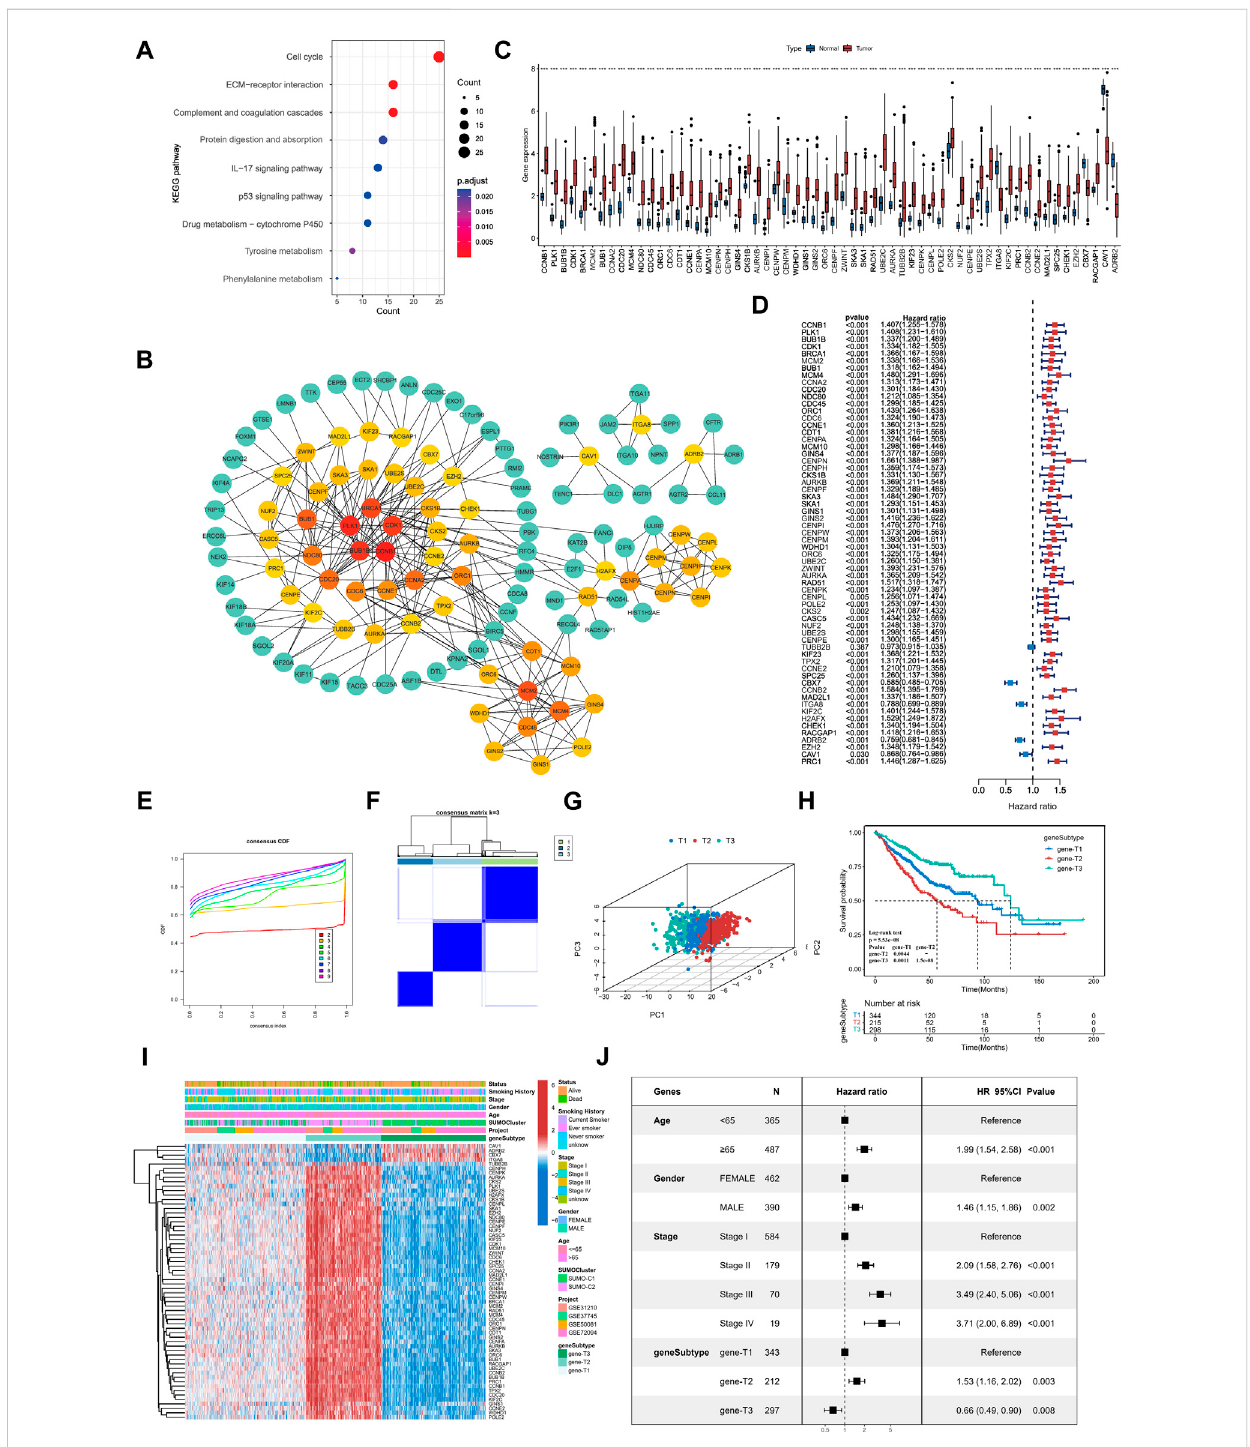
FIGURE 5 Identi fi cation of key genes differentially expressed between SUMOylation patterns and characterization of SUMOylation genomic subtypes. (A) Functional annotation of SUMOylation differential genes by KEGG enrichment analysis. (B) The Protein-Protein Interaction Network (PPI) of key genes associated with SUMOylation. (C) Differential expression of SUMOylation key genes between lung adenocarcinoma and normal tissue samples. (D) Prognostic value analysis of SUMOylation key genes for lung adenocarcinoma. (E) CDF curves for unsupervised clustering with K = 2 to 9. (F) ConsensusclusteringgraphwithK=3. (G) PCAofSUMOylationgenomicsubtypesbasedonkeygenestranscriptome. (H) Kaplan-Meiercurvesforoverall survival OS for the three SUMOylation genomic subtypes. (Log-Rank test p = 5.53e-08, p -value less than 0.001 for both comparisons). (I) The heatmap shows the identi fi cation of 3 different genomic subtypes by unsupervised clustering based on 62 SUMOylation-associated key genes. Annotated with Status, Smoking History, Stage, Gender, Age, SUMOylation patterns, GEO cohort, and genomic subtypes. Red is high expression and blue is low expression. (J)